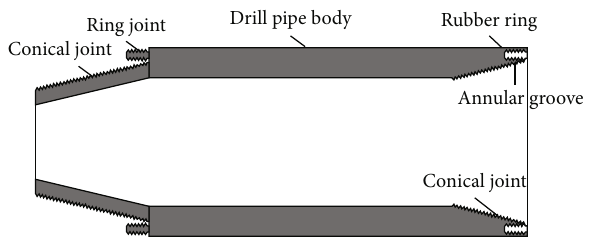
Figure 5: Improved high-pressure drill pipe. Table 1: Test parameters in the fi rst punching